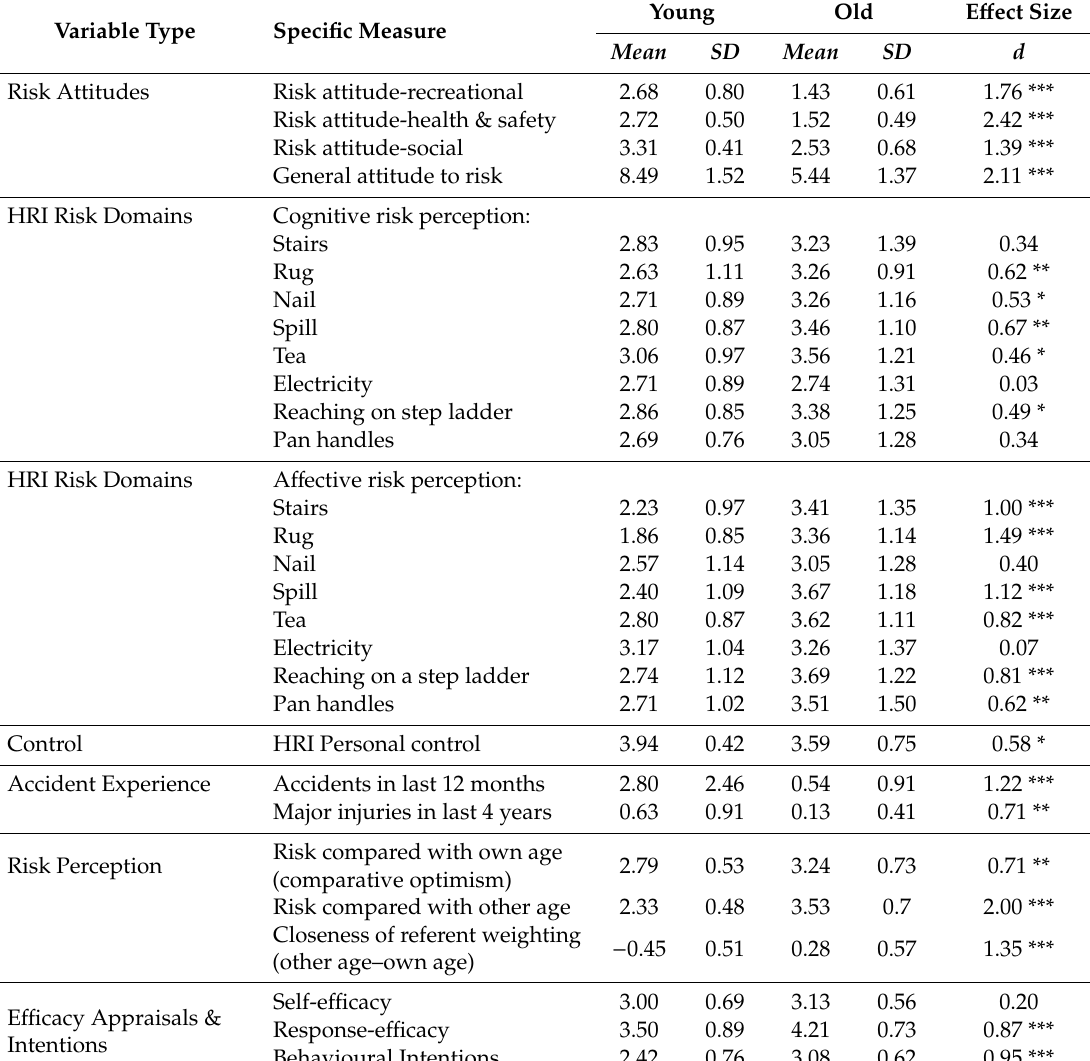
Table 1. Means and standard deviations for younger and older groups for risk perception and worry for each HRI hazard along with risk attitudes, ratings for control, past accidents, overall risk perceptions, e ffi cacy appraisals, and behavioural intentions to remove